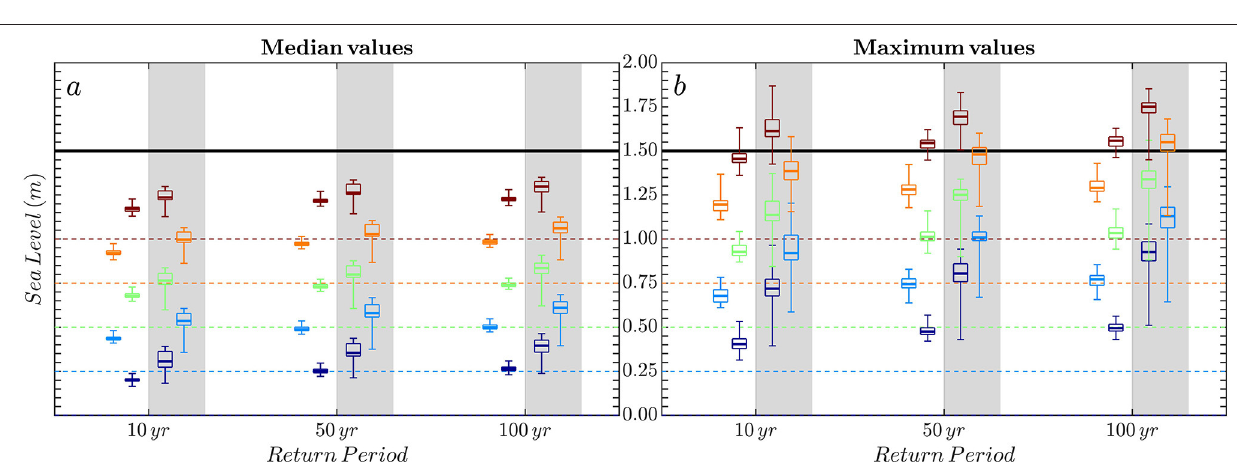
Note that this may correspond to a 1 in 100-year events reaching level conditions. It also occurs for moderate extreme waves with a return period of 10-years in combination with + 1 m of mean sea level (this case is also provided in the Supplementary Video 1